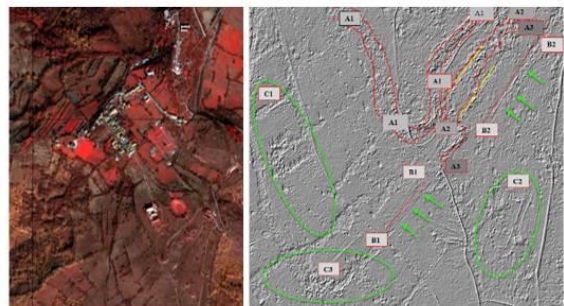
Figure 5. Morphological filters (45°) highlight some particular features linked to archaeological emplacements observed in ground surveys. Detail of the RGB color representation of the Geo-Eye multispectral image; morphological filters (45°) highlight quarries (A1, A2, A3) and other archaeological defensive structures (B1, B2) (C1, C2, C3) covered by debris and vegetation.